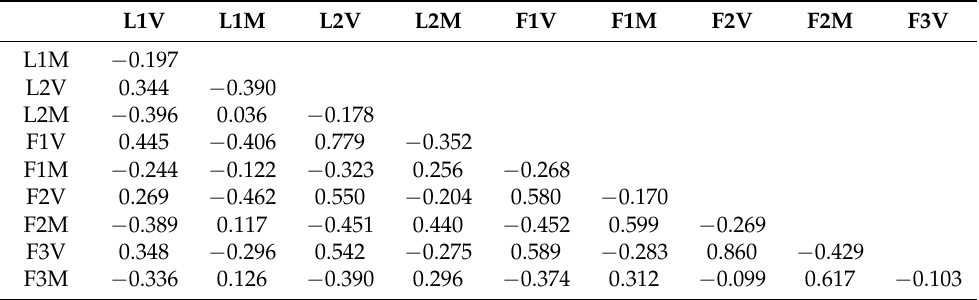
Figure 4. Principal component analysis (PCA) of the different stages of P. ziziphi according to the different treatment rates ( A ); double projection diagram for the two components ( B ).